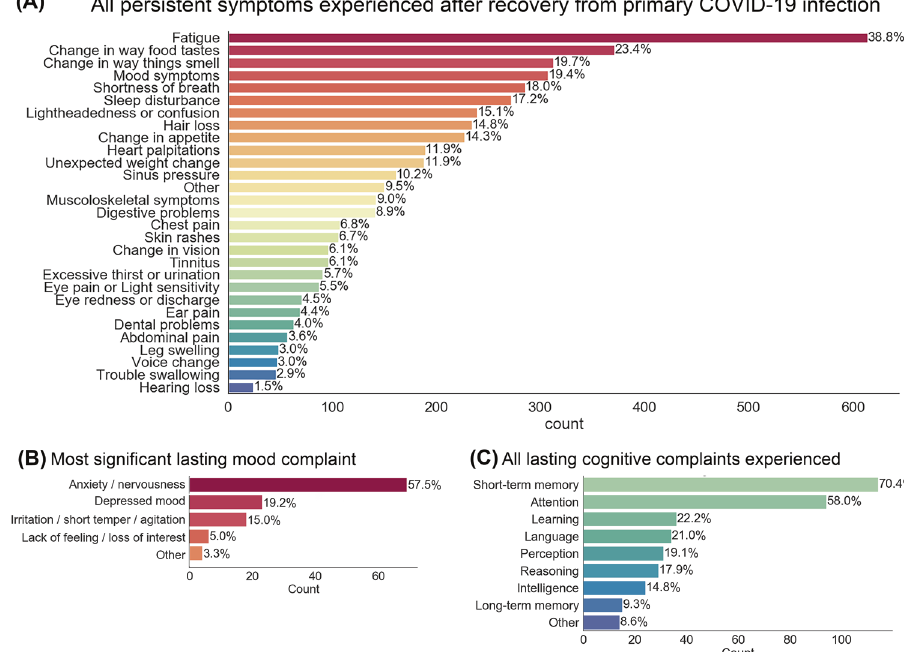
Fig. 1 Prevalence of speci fi c symptoms experienced by individuals reporting long-term sequelae following recovery from COVID-19. 70.6% of participants reported presence of one or more lasting symptom after recovery. The mean number of lingering symptoms reported was 3.06 (SD = 3.73). Chief lingering symptom complaints in the sample were fatigue, change in the perception of taste and smell, and mood symptoms ( A ). Follow up questions in a subset of participants provide insight into the primary kinds of mood ( B ) and cognitive ( C ) complaints expereinced. The proportion of participants that reported mood or cognitive/memory complaints following illness were 19.4% and 25.1%,